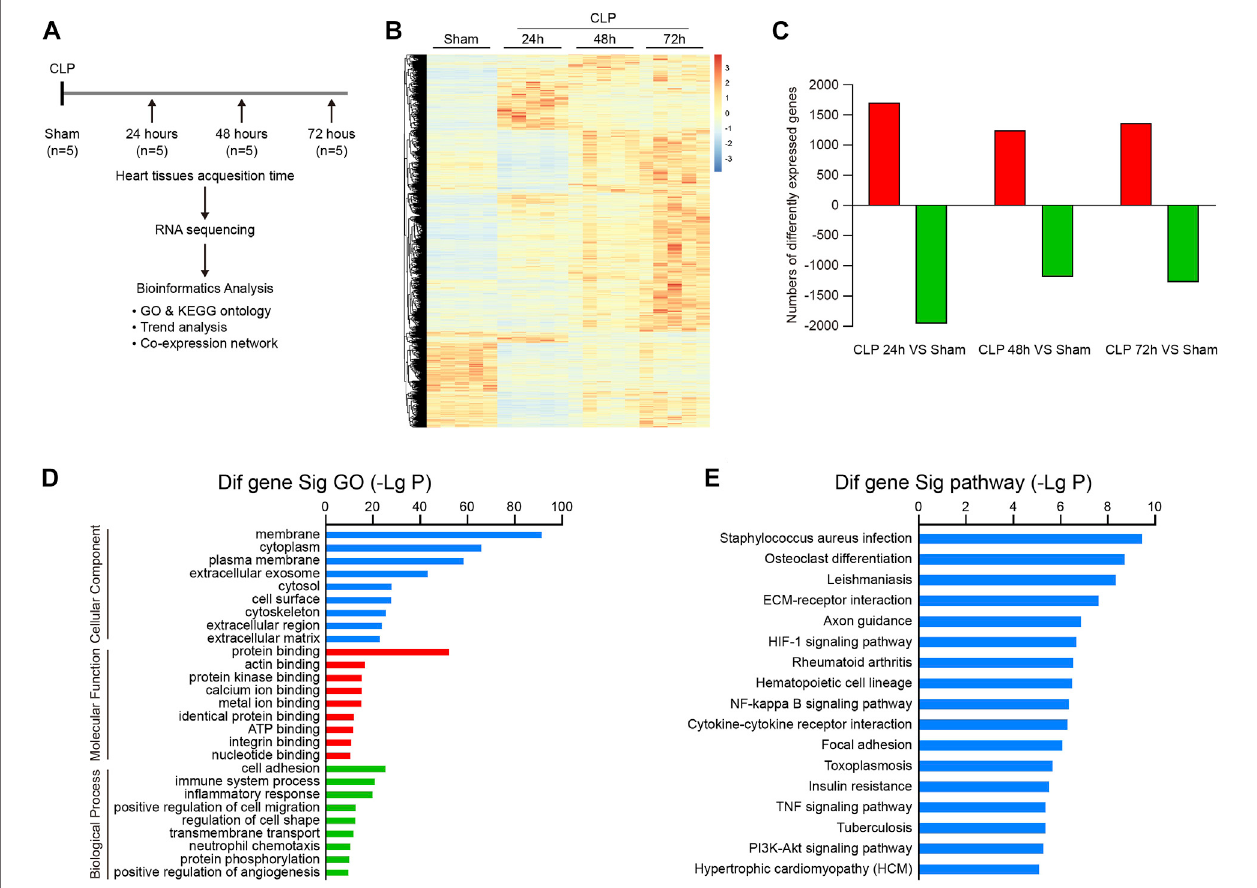
FIGURE 2 | Analysis of gene ontology (GO) terms and KEGG pathways in septic hearts. (A) Schematic diagram of the experimental design for RNA sequencing analysis. (B) The heat map of differentially expressed genes (DEGs) between septic myocardium and sham control at 24, 48, and 72 h (n = 5 per group). The red or blue color represents upregulation or downregulation of genes, respectively. (C) Quanti fi cation of signi fi cantly upregulated or downregulated genes. (D) GO enrichment analysis of DEGs involved in cellular components, molecular functions, and biological processes in hearts after CLP operation. (E) KEGG pathways enrichment analysis of DEGs in septic